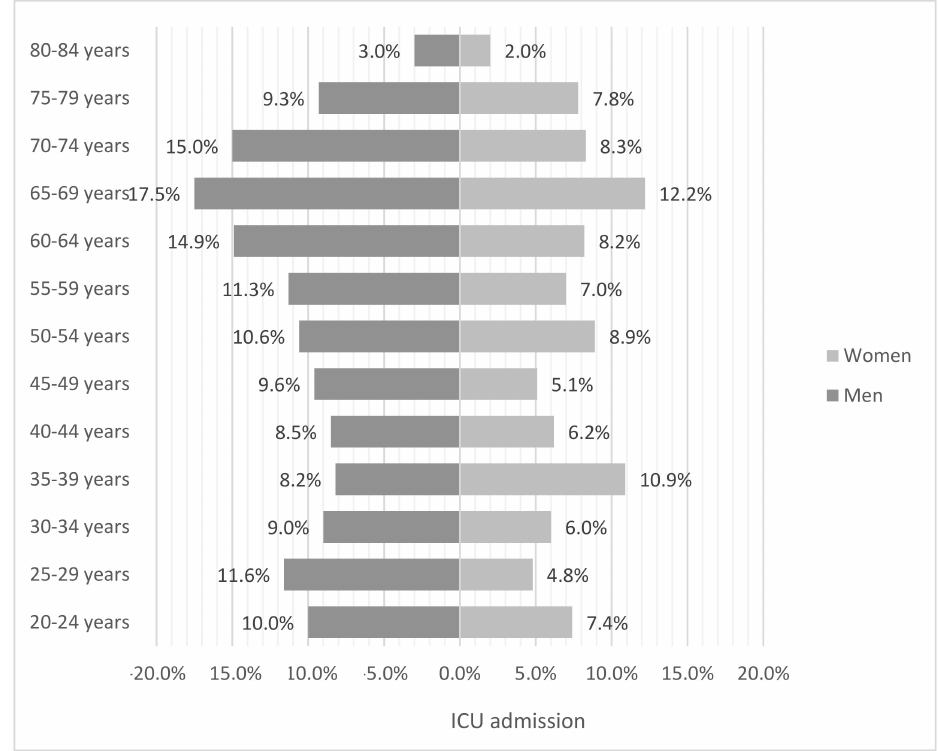
Figure 3. Intensive Care Unit (ICU) admission by sex and age